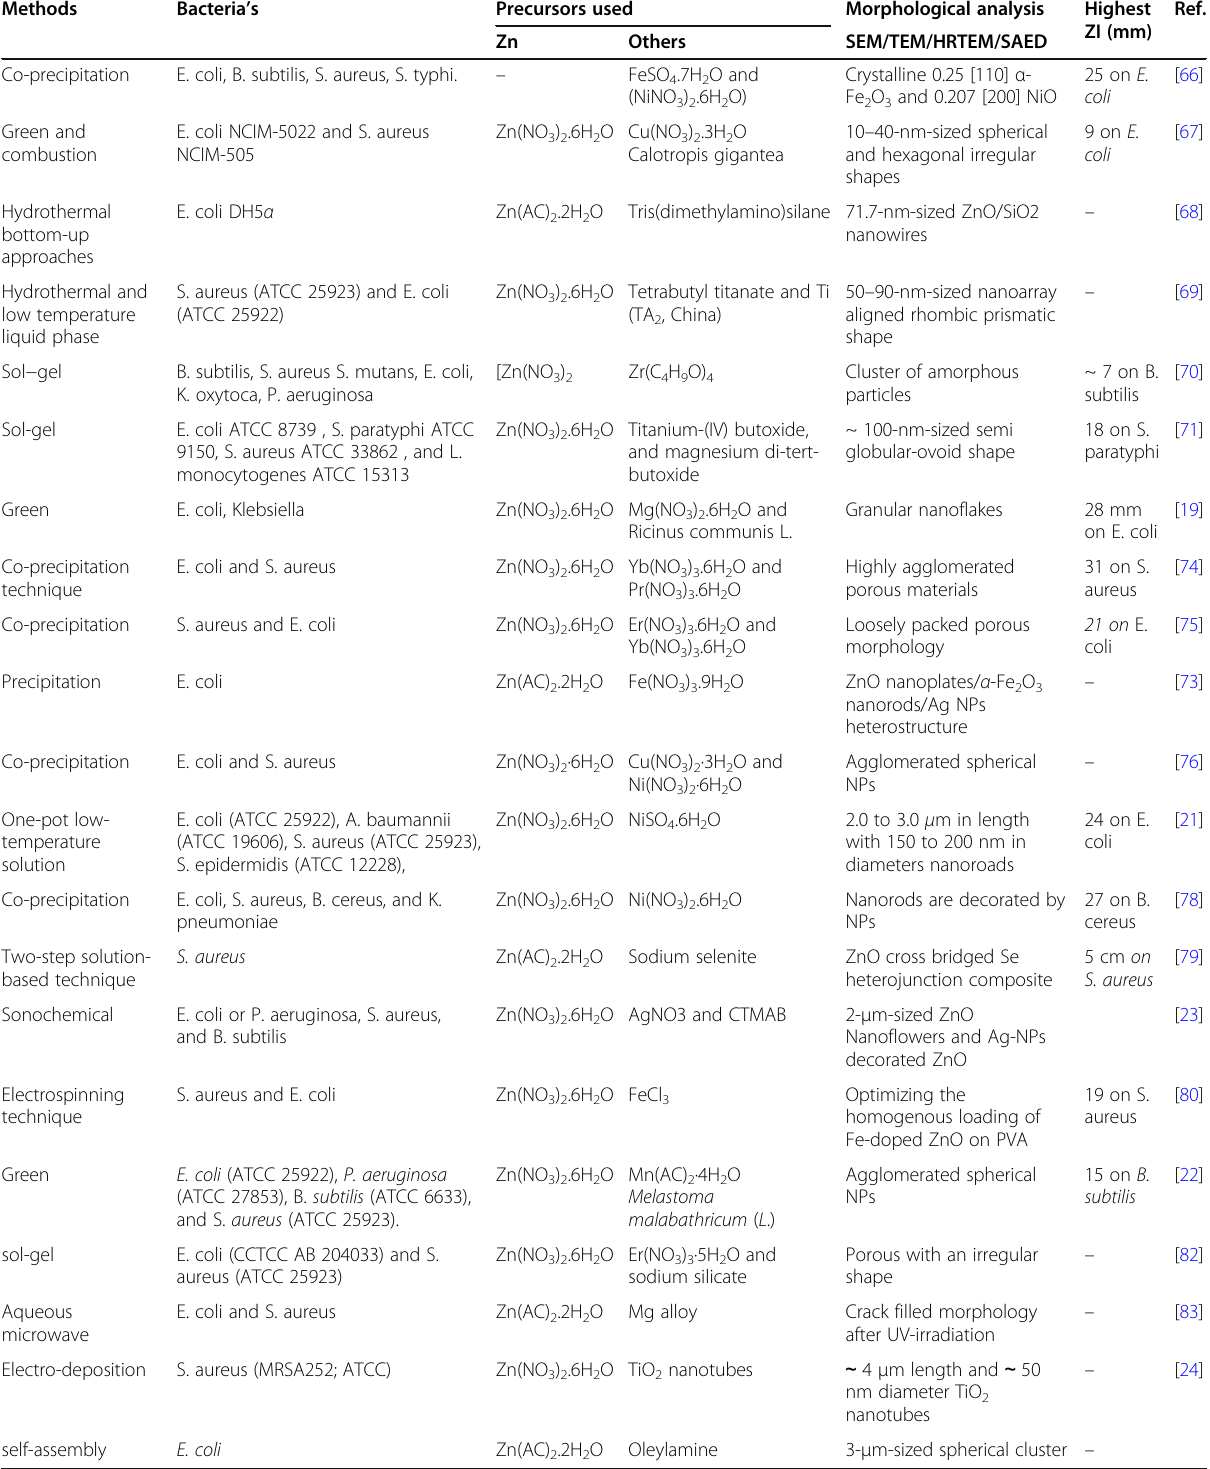
Table 2 A set of parameters obtained for antibacterial activities of ZnO-based composites/dopant and different optimization